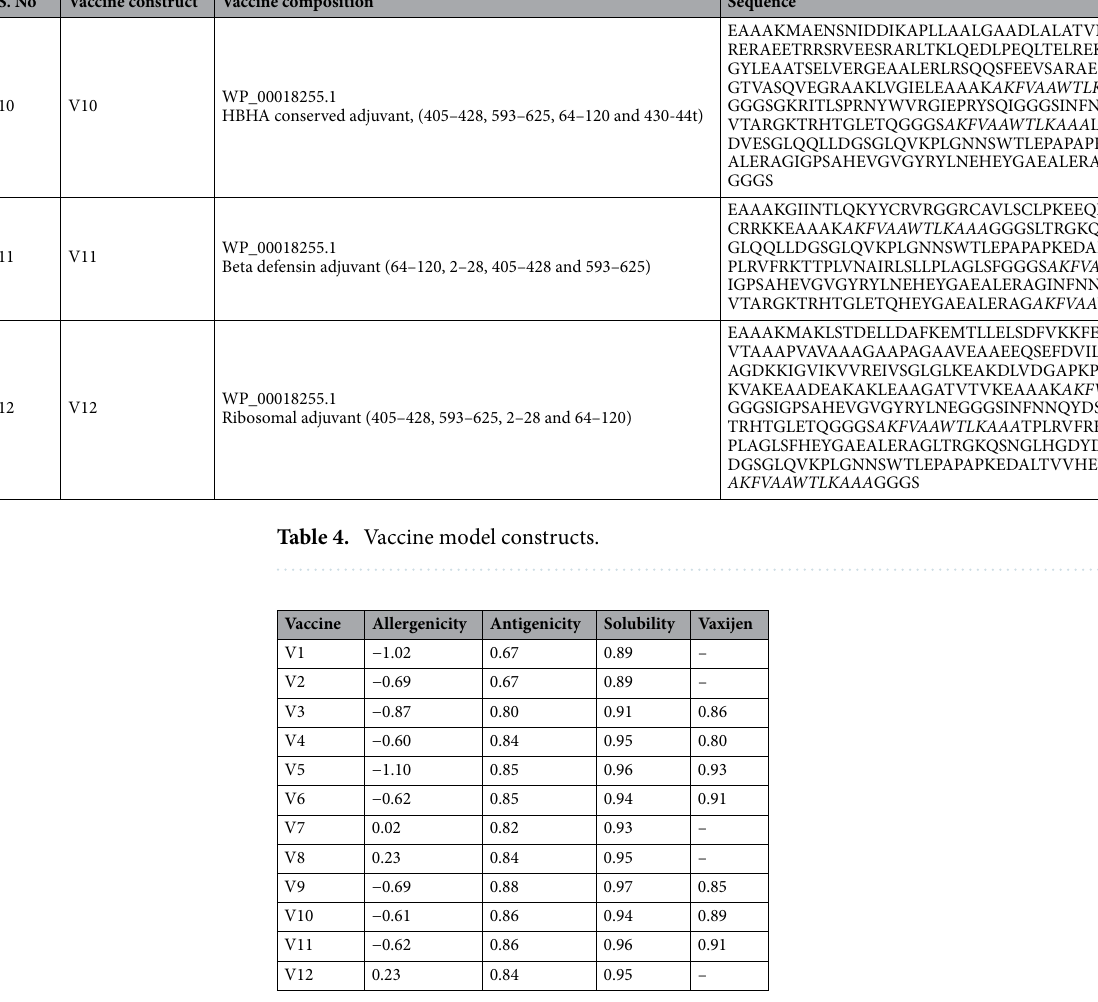
Table 5. Allergenicity, antigenicity, solubility predicted for 12 vaccine